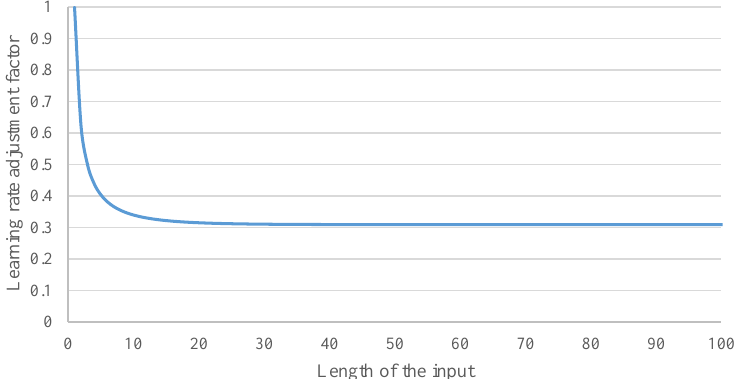
Figure 5. Illustration of the learning rate adjustment factor over different lengths of inputs for the last IndRNN